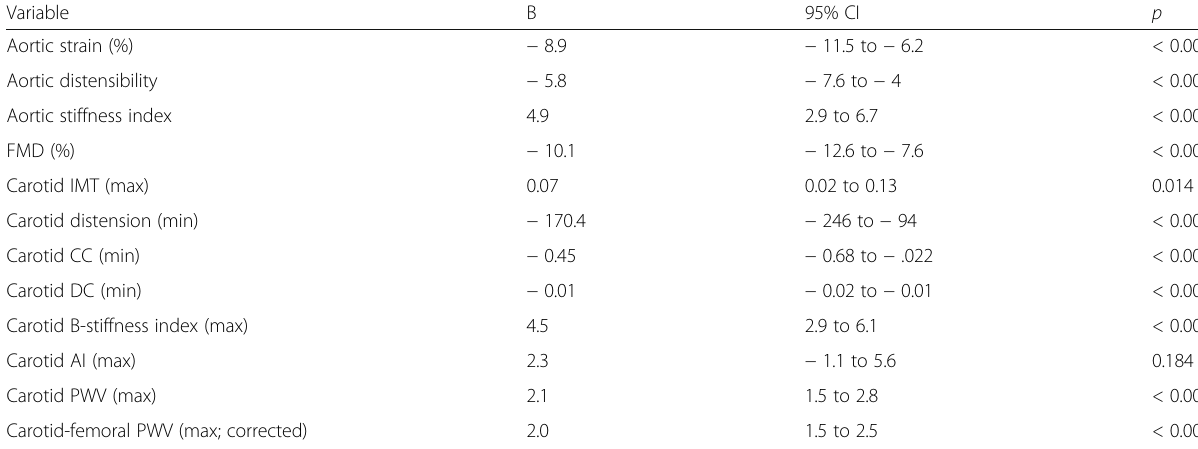
Table 3 Linear regression analysis to predict arterial stiffness parameters and carotid IMT according to SLE patient/control categorization, after adjusting for diabetes mellitus and hypertension Variable